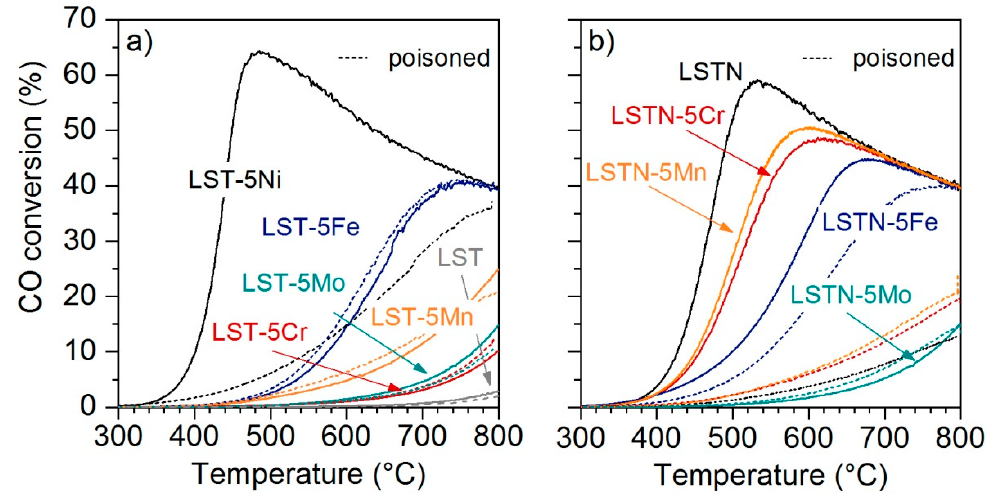
Figure 3. ( a ) WGS activity of LST impregnated with Cr (red), Fe (blue), Mn (orange), Mo (turquoise) and Ni (black) before (continuous lines) and after (dotted lines) catalyst poisoning with 50 ppm H 2 S. ( b ) WGS activity of LSTN (black), as well as LSTN impregnated with Cr (red), Fe (blue), Mn (orange) and Mo (turquoise).